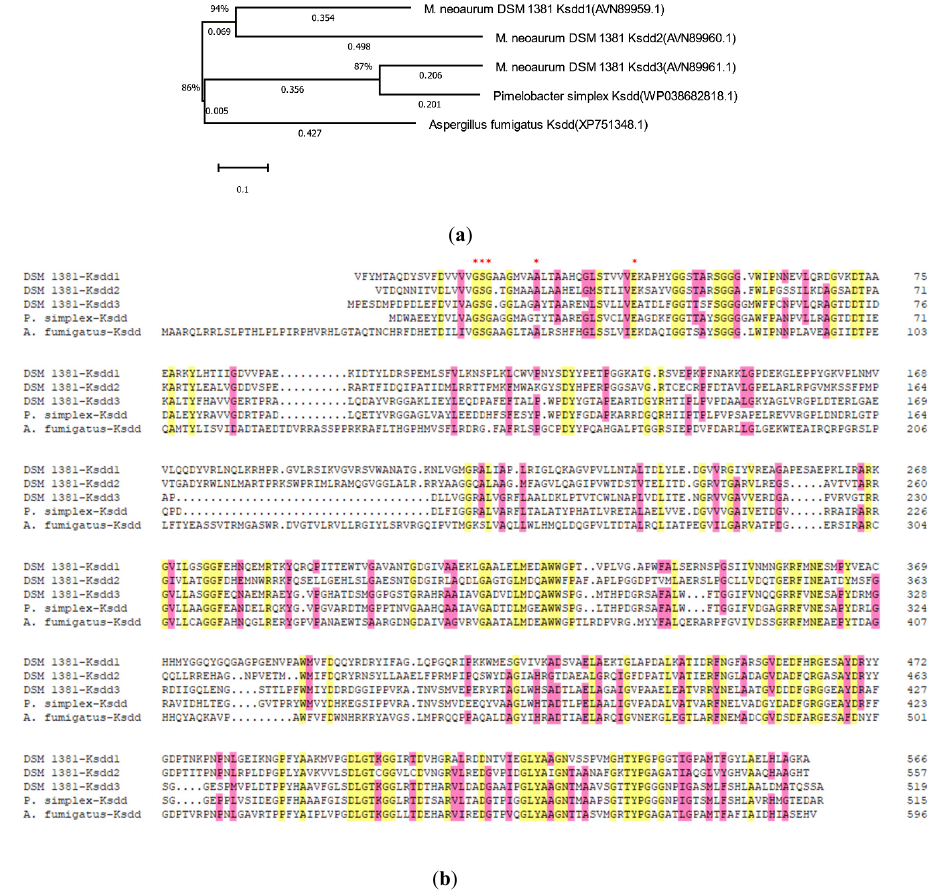
Figure 2. Phylogenetic tree and sequence alignment analysis of 3-ketosteroid- ∆ 1-dehydrogenase (KSDD). ( a ) The phylogenetic tree of five KSDD enzymes from different species. 1,000 replicates were set to generate bootstrap values when conducting analysis. The numbers below the lines represent the evolutionary distance. ( b ) The sequence alignment of five KSDDs. DSM 1381-Ksdd1, DSM 1381-Ksdd2, DSM1381-Ksdd3, Ksddfrom M.neoaurum DSM1381; A.fumigayus-Ksdd, Ksddfrom Aspergillusfumigatus ; P.simples-Ksdd, Ksddfrom Pimelobactersimplex. AconservedsequenceforFAD-bindingregionisindicated by